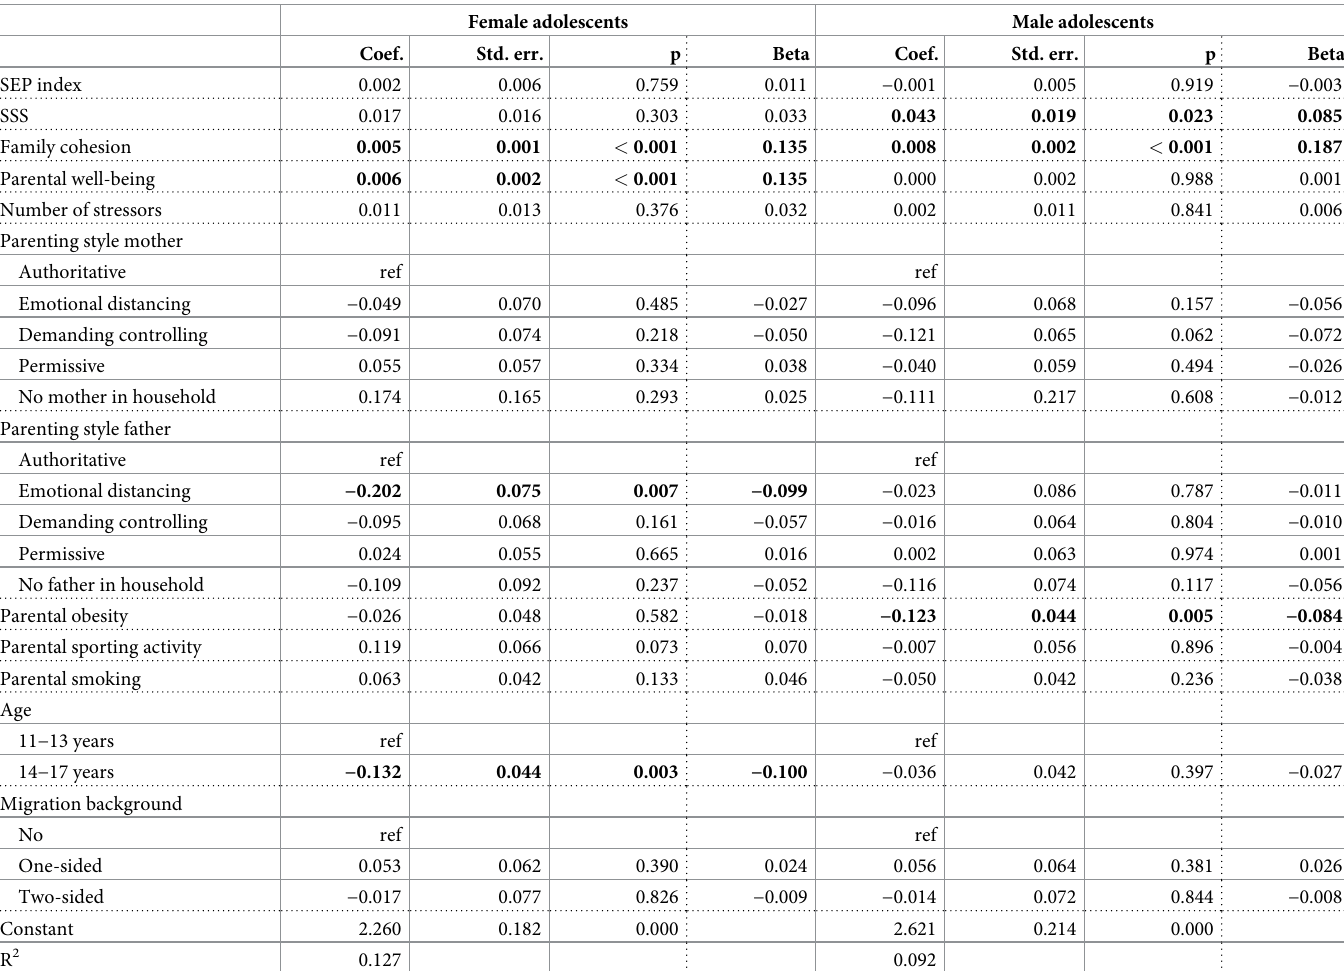
Table 4. Coefficients for SRH in female and male adolescents (linear regressions, full model with SEP index and SSS). Female adolescents Male adolescents Coef. Std.